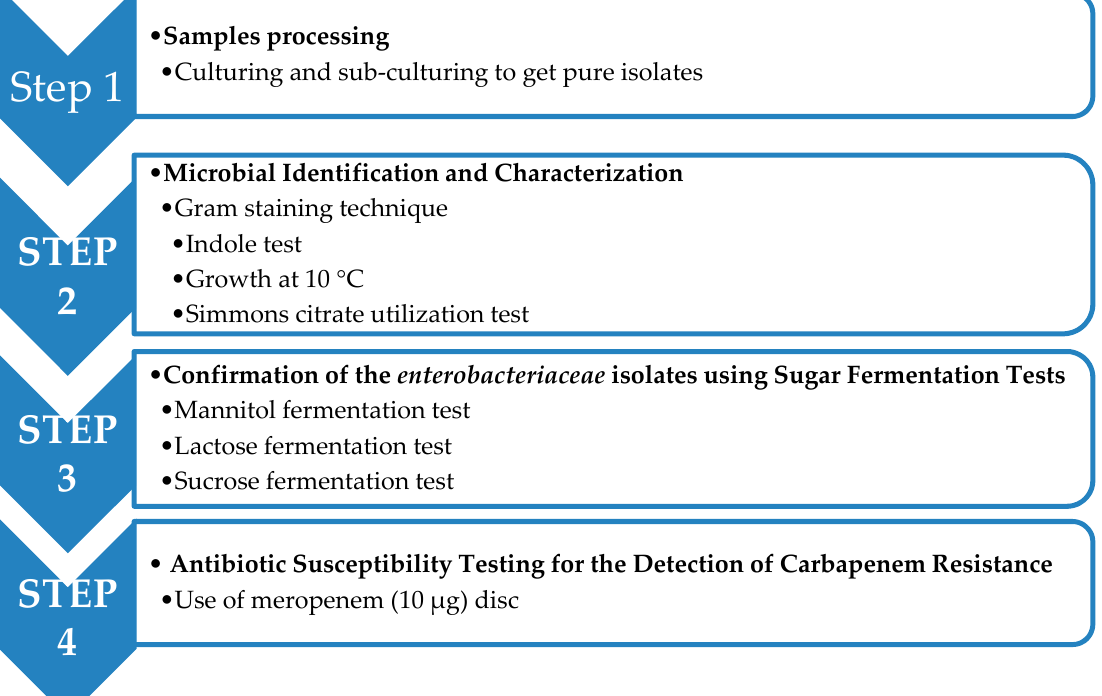
Figure 1. A flowchart of the detection of the Carbapenem-resistant enterobacteriaceae.